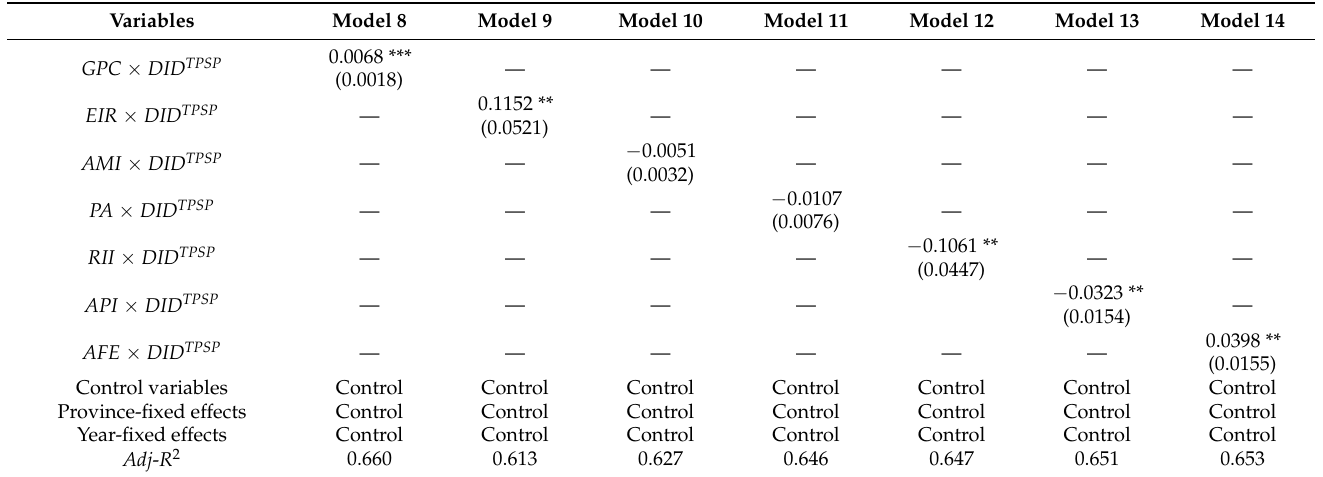
Table 5. Mechanism analysis results of the